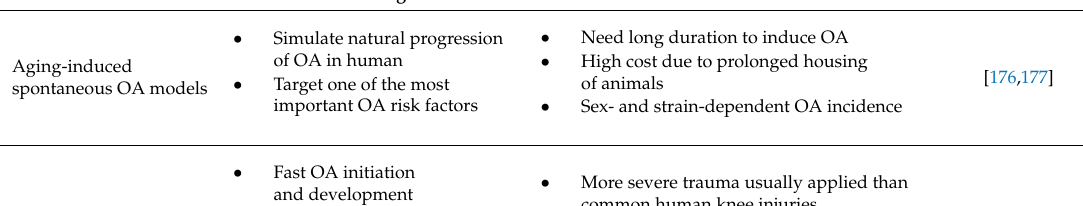
Table 2. Advantages and limitations of current animal models for studying OA. In Vivo